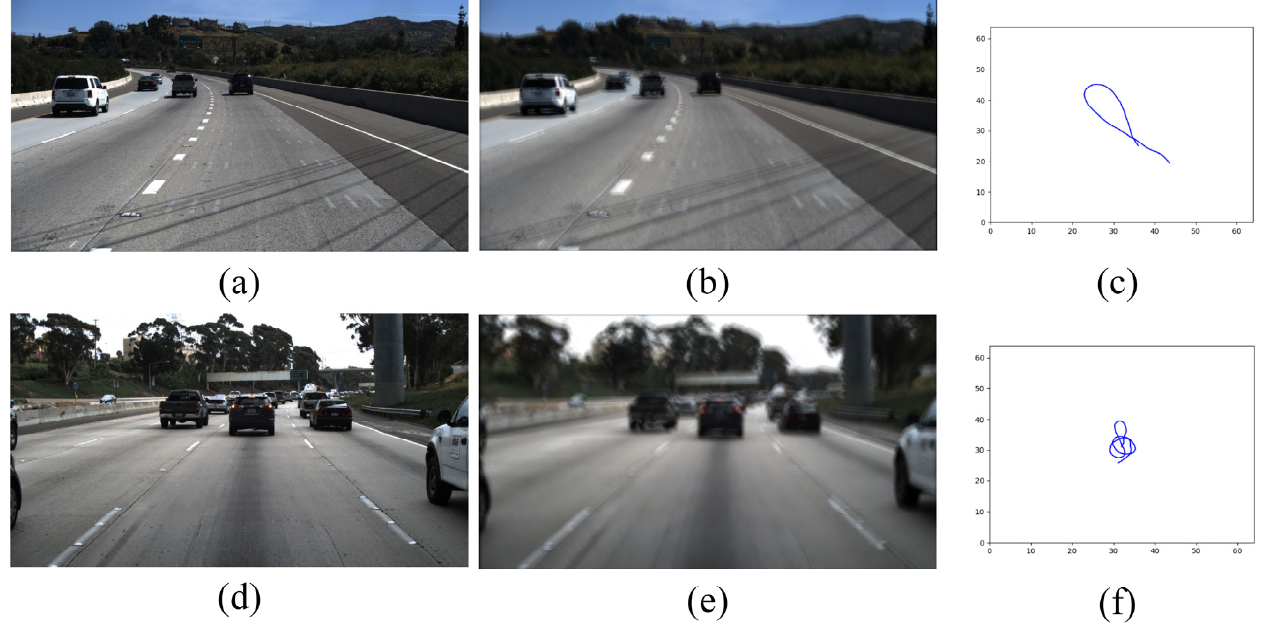
Figure 2. The examples of blurred images in the constructed blur dataset. ( a , d ) represent the clear images, ( b , e ) represent the blurred images, ( c , f ) are the generated camera motion trajectories.